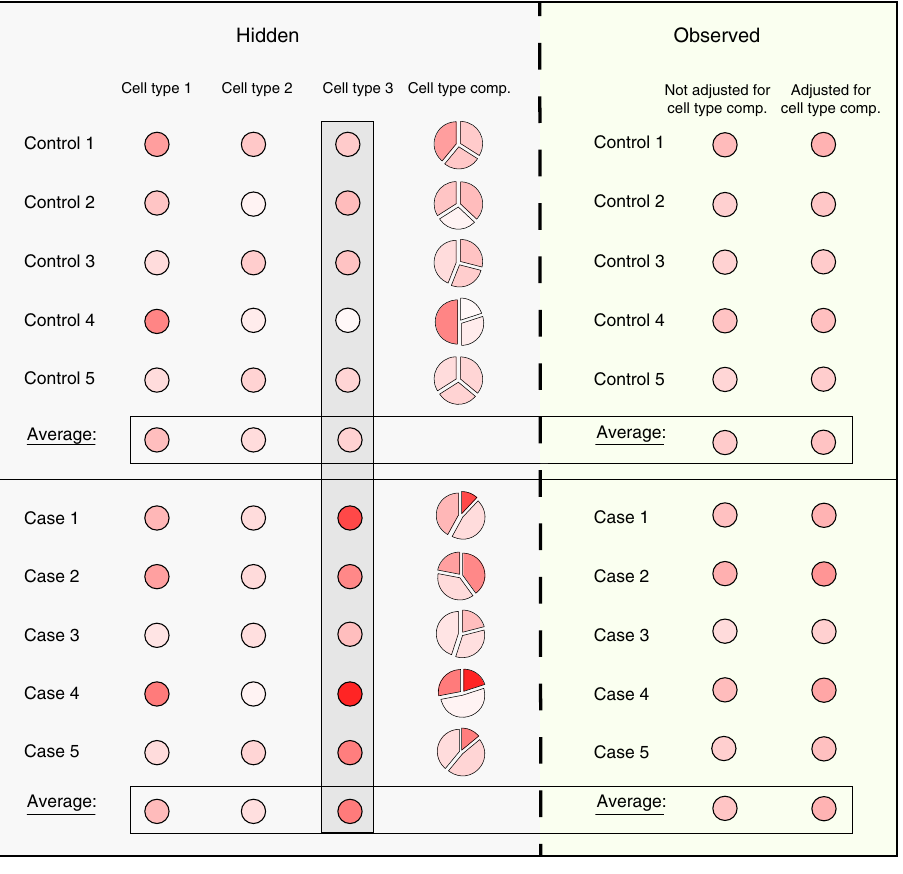
Fig. 1 Observed bulk methylation levels may obscure cell-type-speci fi c signals. Neither the observed methylation levels nor the observed levels after adjusting for the variability in cell-type composition can demonstrate a clear difference between cases and controls, in spite of a clear (unobserved) difference in cell type 3. Methylation levels are represented by a gradient of red color, and adjusted observed levels were calculated for each sample by removing the cell-type-speci fi c mean levels, weighted by its cell-type